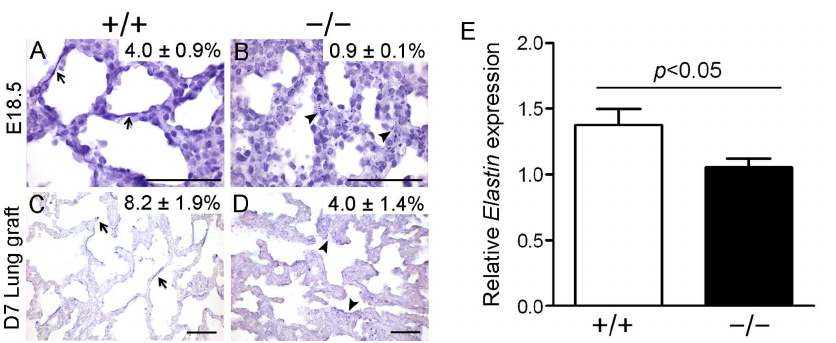
Figure 6. Impaired elastin deposition in E18.5 Fstl1 2 / 2 lungs and D7 Fstl1 2 / 2 lung allografts. Sections of fetal lung tissues and lung allografts were Weigert stained to visualize the deposition of elastic fibers. (A) E18.5 WT lung tissue, (B) E18.5 Fstl1 2 / 2 lung tissue, (C) day 7 WT lung allograft, (D) day 7 Fstl1 2 / 2 lung allograft. Elastic fibers were localized along the respiratory saccules and at the tip of the growing septa (arrows) in E18.5 WT lung (A) and D7 WT lung allografts (C). Elastin fibers could be barely seen in E18.5 Fstl1 2 / 2 lung (B, arrowheads) and showed a disorganized deposition (D, arrowheads) in D7 Fstl1 2 / 2 lung allograft when compared to their WT controls. Quantitative image analysis showed that Fstl1 deletion reduced the elastin fiber density, expressed as a percentage of lung parenchyma, in Fstl1 2 / 2 lungs and allografts. Data are shown in the top right corner of each diagram ( P , 0.05). Scale bar, 50 m m. (E) Elastin production was decreased in E18.5 Fstl1 2 / 2 lungs using qRT-PCR analysis (n=6). The graph represents the mean 6 SEM of three independent experiments.